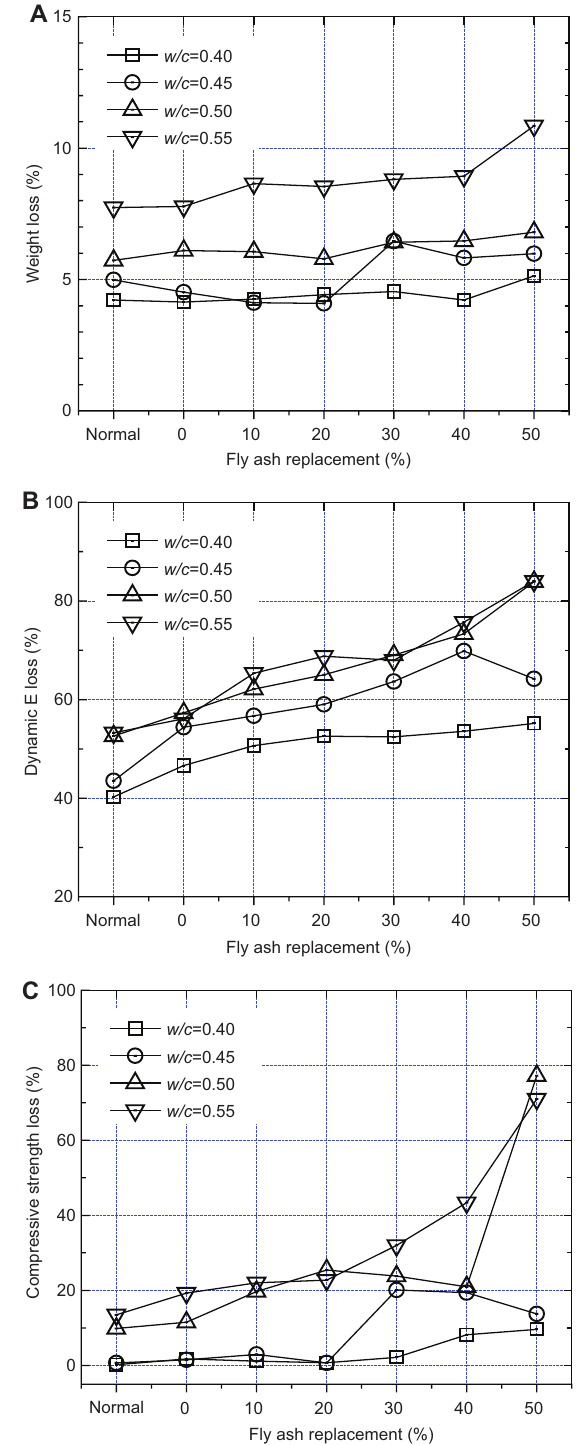
Figure 9 (A) Mass, (B) dynamic modulus, and (C) compressive strength loss after sulfate attack.